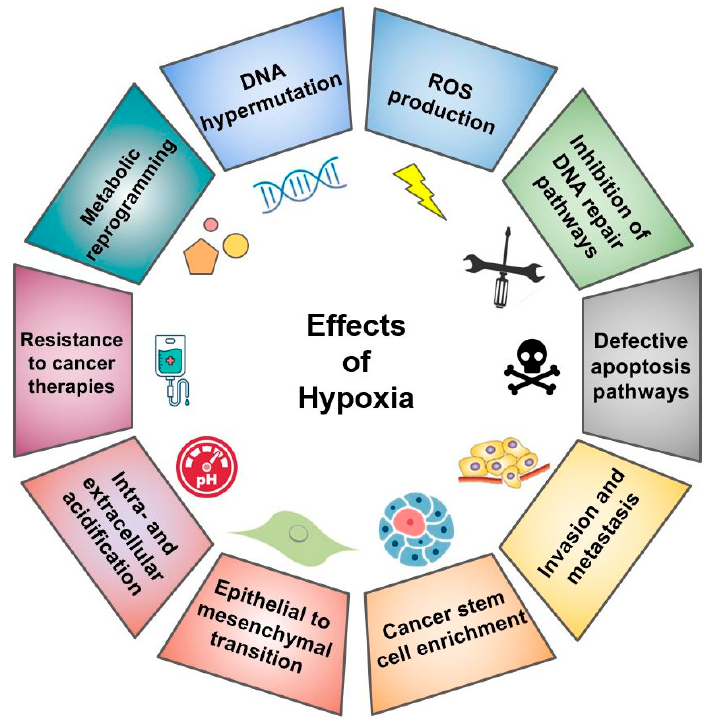
Figure 1. The spectrum of effects of hypoxia on cancer cells. Hypoxia affects cancer cell fate, genet- ics, metabolism, and clinicopathology. ROS: Reactive oxygen species. DNA: Deoxyribonucleic